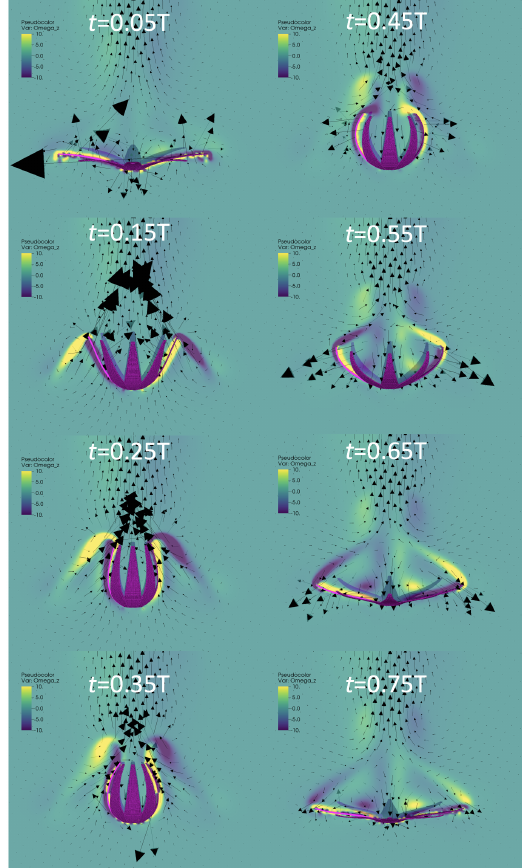
Fig. 7: The z -component of vorticity and the velocity vector field taken on a 2D plane through the central axis of the coral at Re f = 80 . This Re f corresponds to a very large, fast pulsing coral polyp. The colormap shows the value of ω z , the arrows point in the direction of flow, and the length of the vectors correspond to the magnitude of the flow. Snapshots are taken during the fourth pulse at times that are 5%, 15%, 25%, 35%, 45%, 55%, 65%, and 75% through the